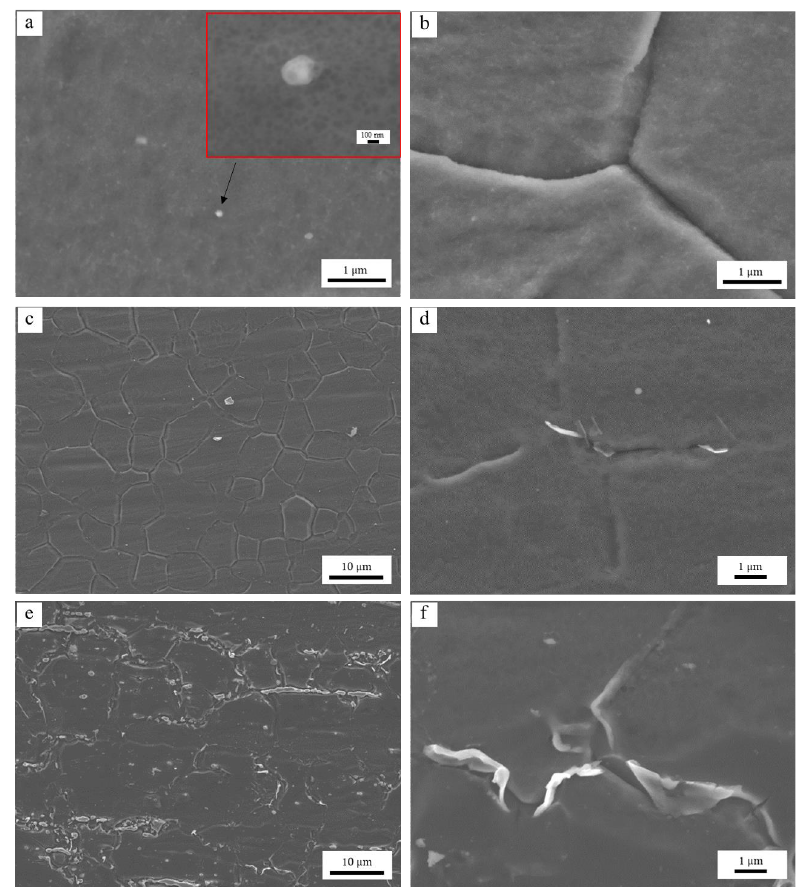
Figure 10. SEM images of the initial ( a , b ) AZ31, ( c , d ) AZ61, and ( e , f ) AZ91 alloy sheets. The red rectangle in ( a ) is an enlarged view of the second phase particle indicated by the black arrow.